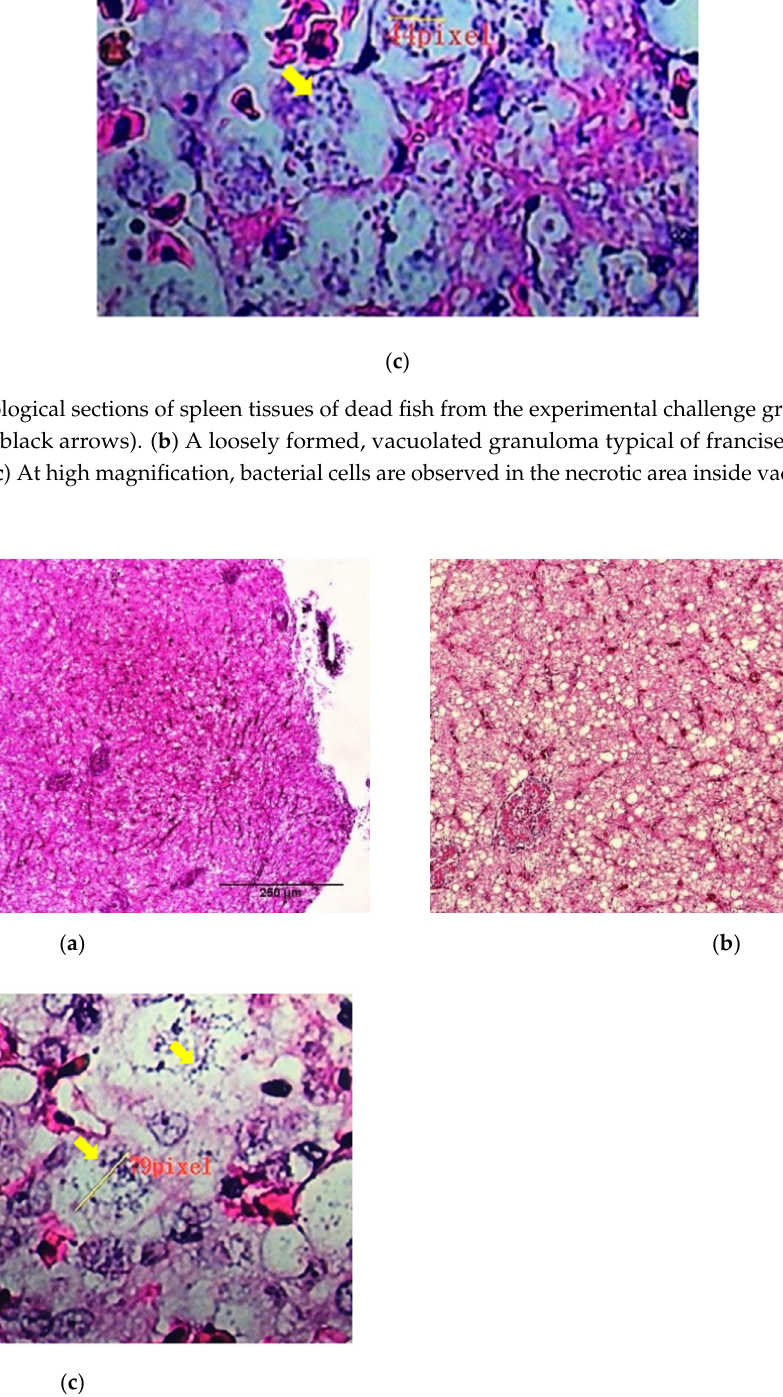
Figure 5. Histopathological sections of liver tissues of dead fish from the experimental challenge group. ( a , b ) Liver shows diffuse congestion (black arrows). ( c ) Vacuoles in the cytoplasm are filled with coccobacilli (yellow arrows) (H&E Stain).